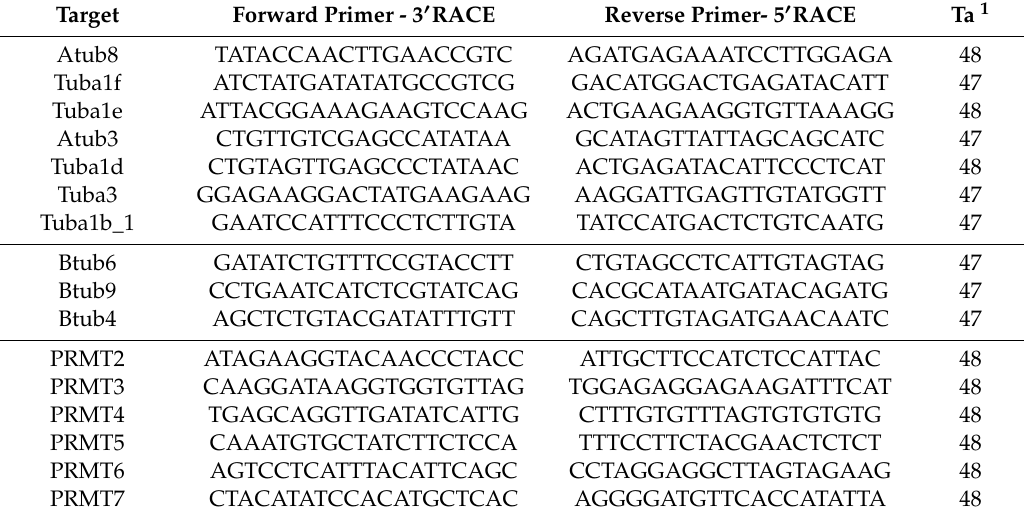
Table 6. Oligonucleotides used as primers for the